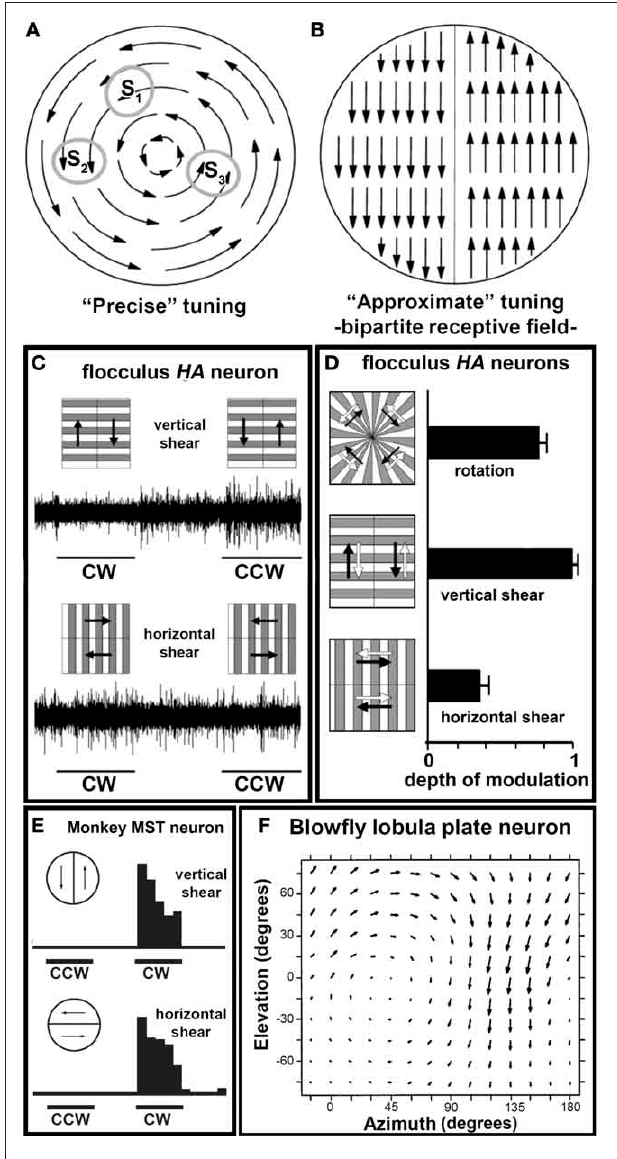
FIGURE 6 | (A) and (B) , Respectively, show receptive fields either “precisely” tuned for rotational optic flow by pooling many local motion detectors with different direction preferences, or “approximately” tuned with a bipartite receptive field structure. (C) Shows the responses of an HA neuron to composite stimuli. The neuron responded much better to vertical shear as opposed to horizontal shear, indicating that it has a bipartite receptive field structure shown in (B) (Winship and Wylie, 2006). (D) Shows the normalized depth of modulation [(CCW − CW)/(CCW + CW)] for all rotation units ( n = 22) in response to the three stimulus configurations illustrated (mean ± s.e.m). Note that the cells responded better to the vertical shear as opposed to the true rotation (Winship and Wylie, 2006). (E) Shows the responses of a rotation sensitive neuron in monkey area MST to similar stimuli. It responded equally well to vertical and horizontal shear, indicating that it has a precisely tuned receptive field (from Tanaka and Saito, 1989). (F) Shows the responses of an optic flow neuron in the lobula plate in blowflies to local stimulation. These neurons have an underlying receptive field with precise tuning (from Krapp et al.,